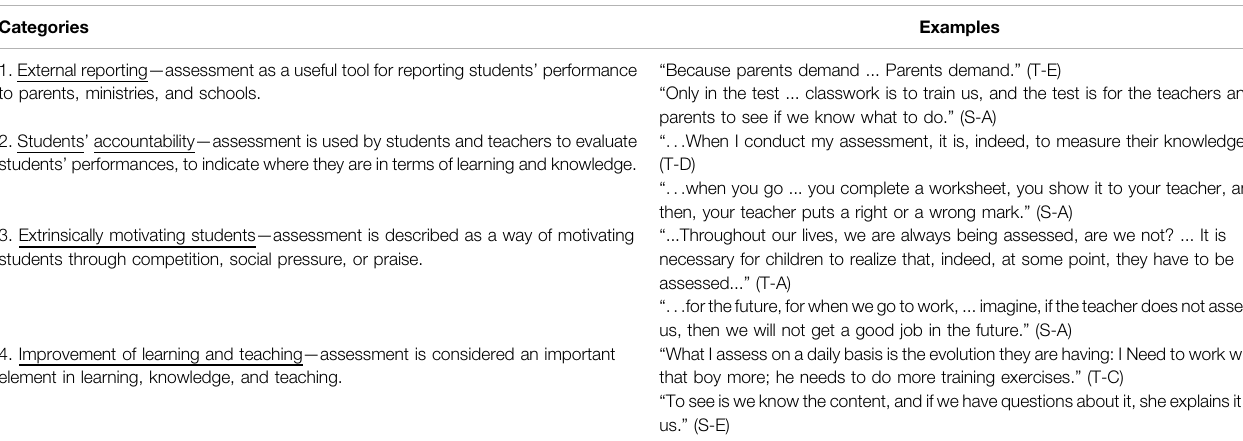
TABLE 2 | Categories mentioned in the interviews and focus